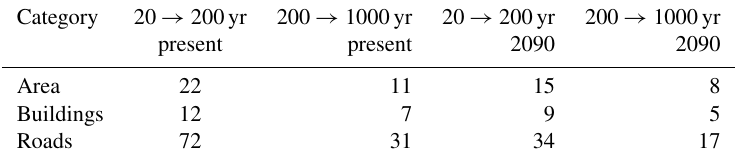
Table 6. The percentage increase in exposed areas, buildings, and roads between different storm surge return heights at present and for 2090. Category 20 → 200yr present present